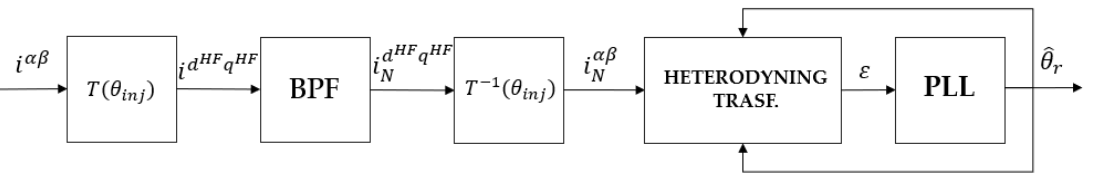
Figure 3. Demodulation algorithm.